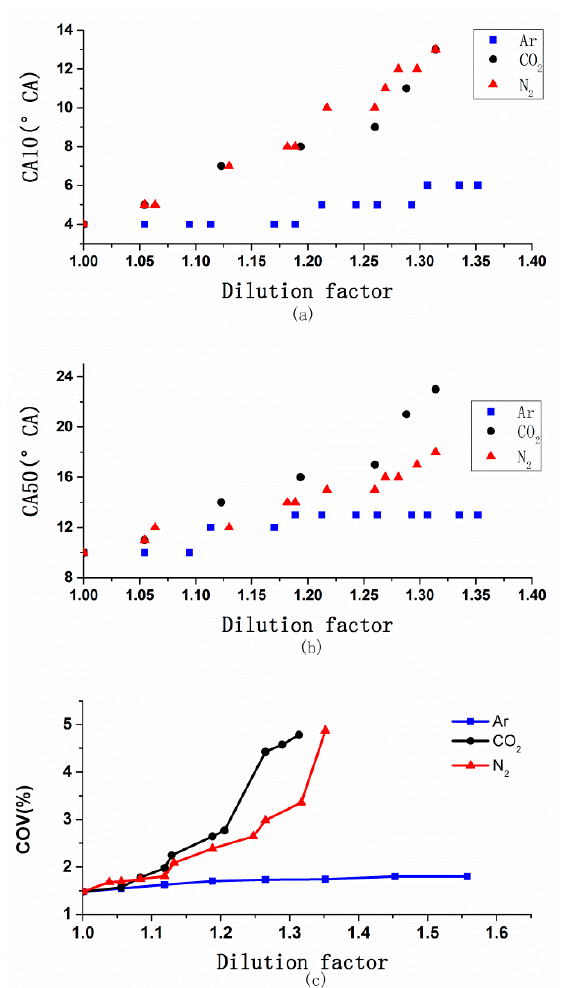
Figure 8. Changes of combustion start point (CA10), combustion center (CA50), cycle-by-cycle combustion variations (COV) vs. the DF of CO 2 , N 2 and Ar, ( a ) CA10 vs. Ar, ( b ) CA50 vs. Ar, ( c ) COV vs. Ar.